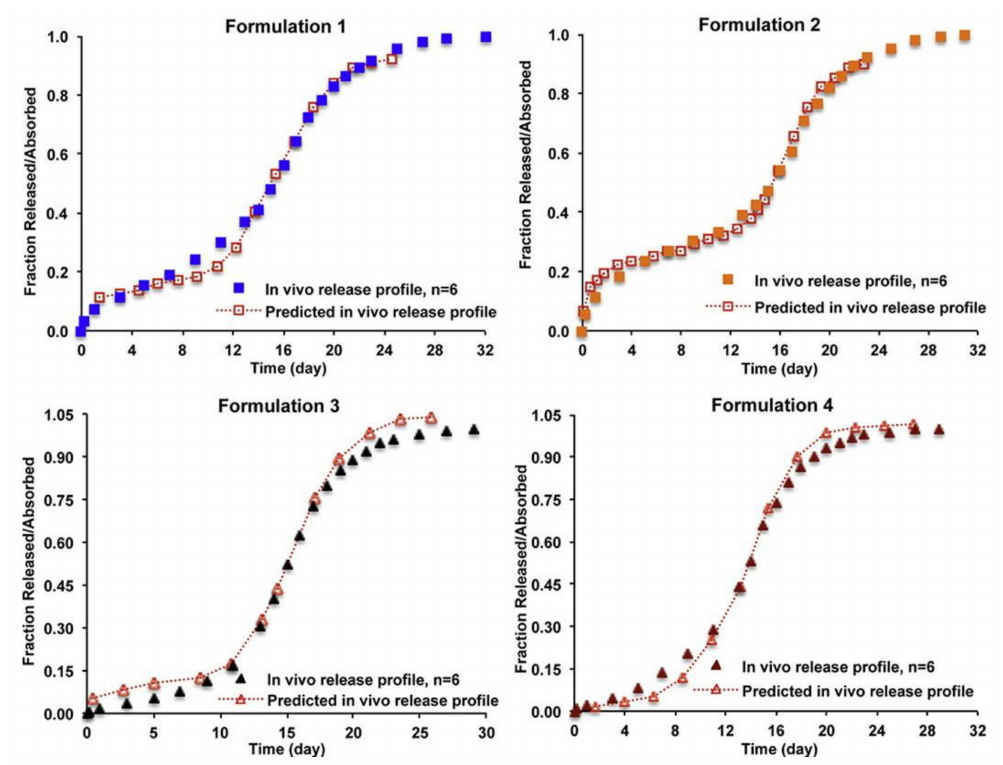
Figure 5. Predicted in vivo release profiles of different risperidone microparticle formulations based on established Level A IVIVCs and the overlapping with their experimental profiles. Reprinted with permission from ref. [81]. Copyright 2015